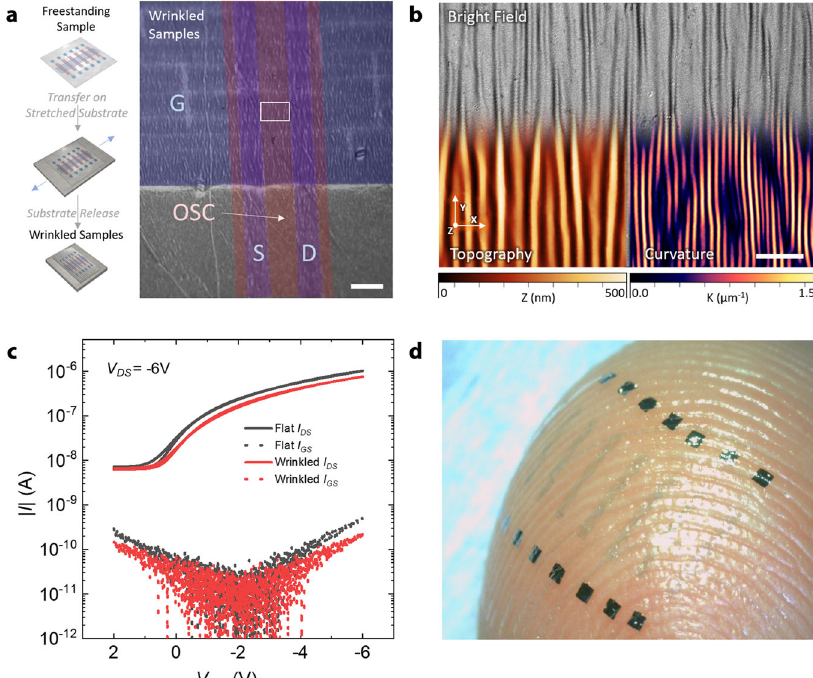
Fig. 4 Mechanical fl exibility and conformability. a Schematic procedure to induce wrinkling in the ultrathin transistor sample (left) and optical picture of the wrinkled transistor device (right, scale bar 100 µ m); the white box indicates the point in which a speci fi c curvature analysis is performed as reported in ( b ). b Merged optical image, topographic and curvature mapping of a wrinkled sample acquired in the active area of the transistor by optical pro fi lometry at ×150 magni fi cation (scale bar 10 µ m); the curvature (K) mapping is calculated by optical pro fi lometry data (details in Supplementary Figs. 8 – 9). c Transfer characteristic curves for an ultrathin device in saturation mode when recollected on a prestretched PDMS substrate ( fl at sample, black line) and after PMDS relaxation, which induces strong buckling on the surface (wrinkled sample, red lines). d A fi lm sample containing an array of devices adhering to the skin to demonstrate conformal adhesion and a high level of transparency.